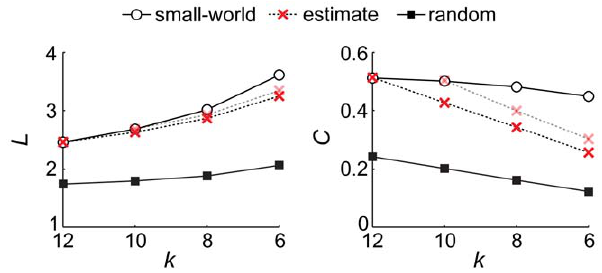
Figure 6. The random removal of edges introduces a bias towards random networks. Shown here is the estimation of the k - dependence for a small-world network (rewiring probability=0.1). Edges were stepwise randomly removed from the original network and the path length ( L ) and clustering coefficient ( C ) were recalculated. This procedure was repeated 200 times, resulting in an average k - dependence estimate. We started this estimation both with a original network having k =10 (dashed black line) and k =12 dashed grey line). Estimates showed a deviation from the simulated k -dependence of the small-world network and depended on the average degree of the original network. Effects were smaller for L compared to C since values are already closer to those for random